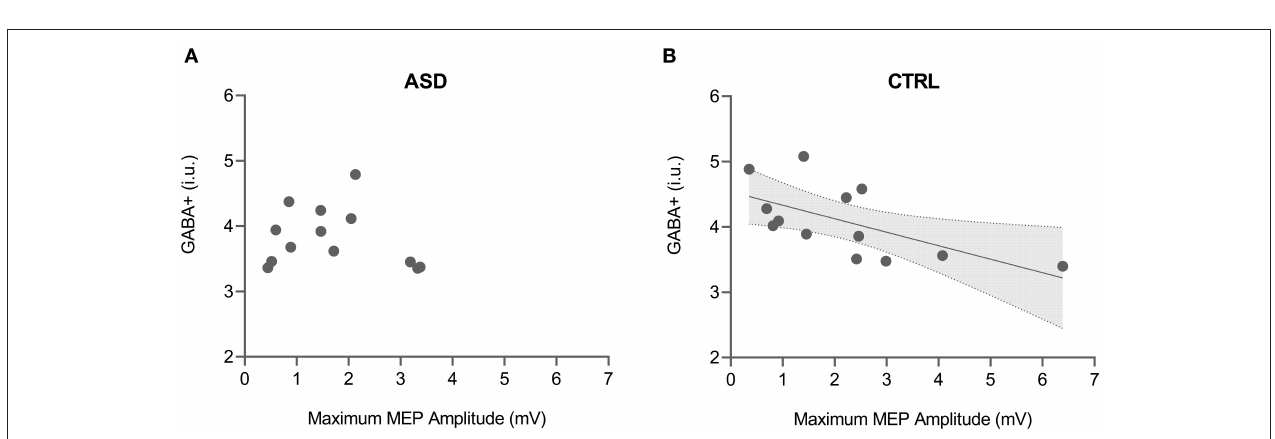
FIGURE 3 | MEP peak-to-peak amplitude for SICI (1, 3, and 5ms) and ICF (10, 15, and 20ms) intervals for ASD and control participants (CTRL). Horizontal lines represent the baseline condition (with no inhibitory or facilitatory effects), obtained by single-pulse TMS for each group and protocol. Inhibition occurs for bars below the horizontal lines, whereas excitation stands above the lines. SE of the means are illustrated in shaded horizontal bands and error bars. # p > 0.05 ASD, Autism Spectrum Disorder group; CTRL, control group; MEP, motor-evoked potential; SICI, short-interval intracortical inhibition; ICF, intracortical facilitation; S.E.; standard error of the mean.